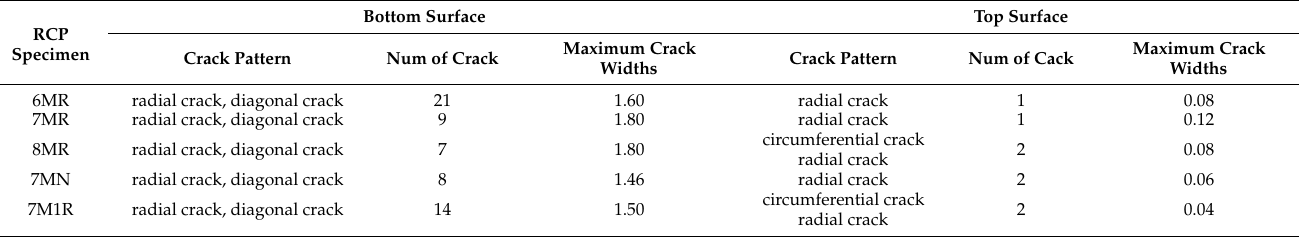
Table 7. Final crack properties of all RCP specimens.